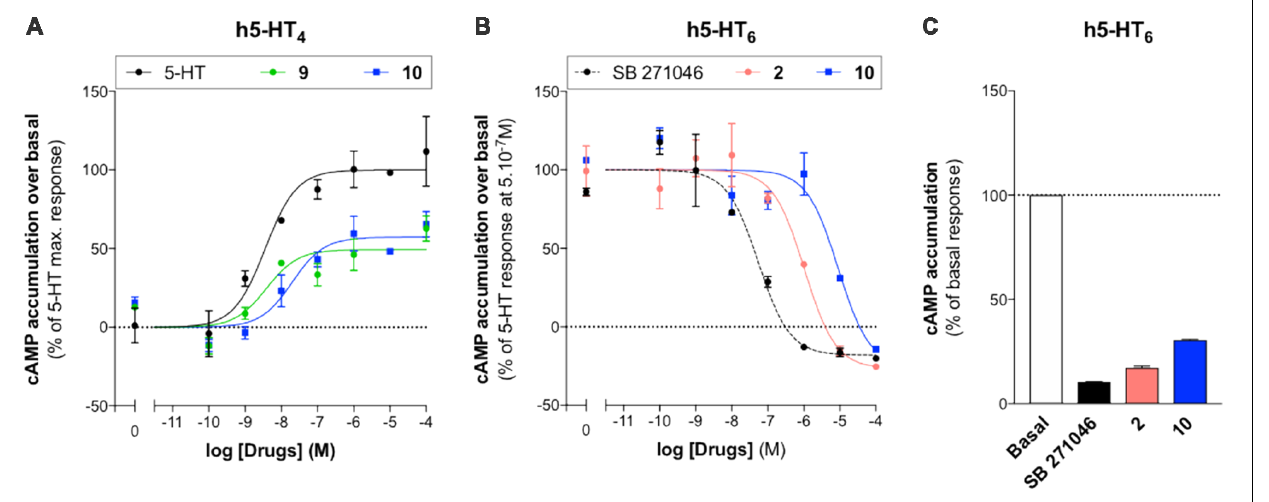
FIGURE 4 | Pharmacological profile of compounds 2 , 9 and 10 . Representative experiments illustrating agonist activities of 9 and 10 towards ( h )5-HT 4 ( a ) R (A) and antagonist activities of SB271046, 2 and 10 towards ( h )5-HT 6 R stimulated with 5.10 − 7 M of 5-HT [ B ; data are means ± standard error of the mean (SEM); n = 2]. (C) Inverse agonist activities of SB271046, 2 and 10 (10 − 4 M) towards ( h )5-HT 6 R in absence of 5-HT (means ± SEM of two independent experiments performed in duplicates).